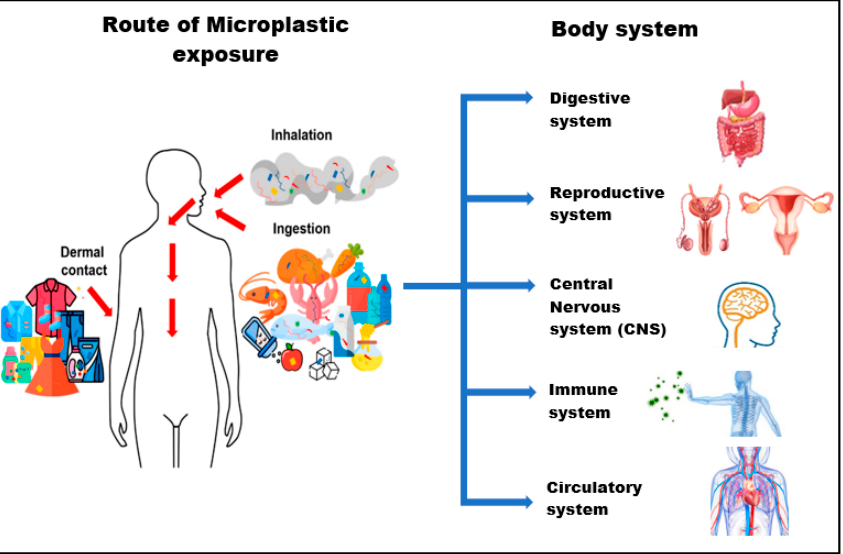
Figure 2. Human exposure to MPs via inhalation, ingestion, and dermal contact. MPs can be translocated to target systems, such as the digestive, reproductive, central nervous, immune, and circulatory systems, which may lead to toxicity effects. [34] © 2021 toxics.